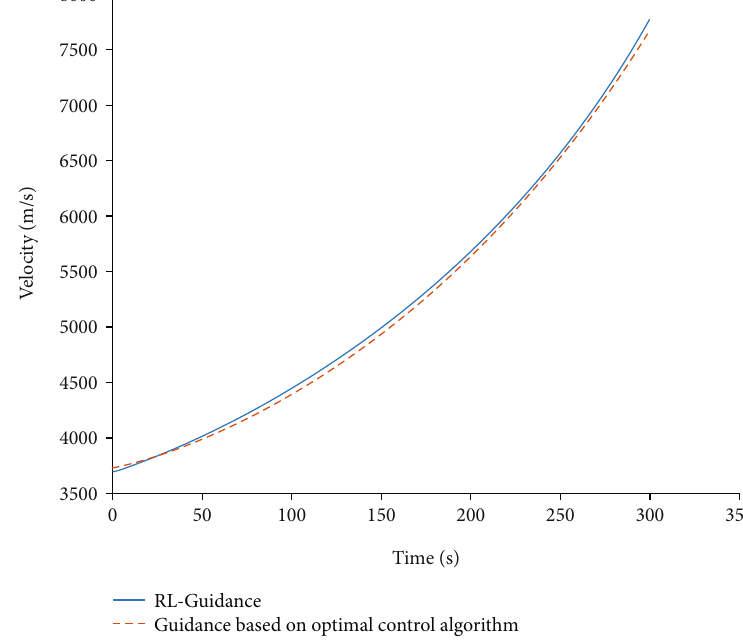
Figure 7: Velocity comparison of RL-guidance and guidance-based optimal control.